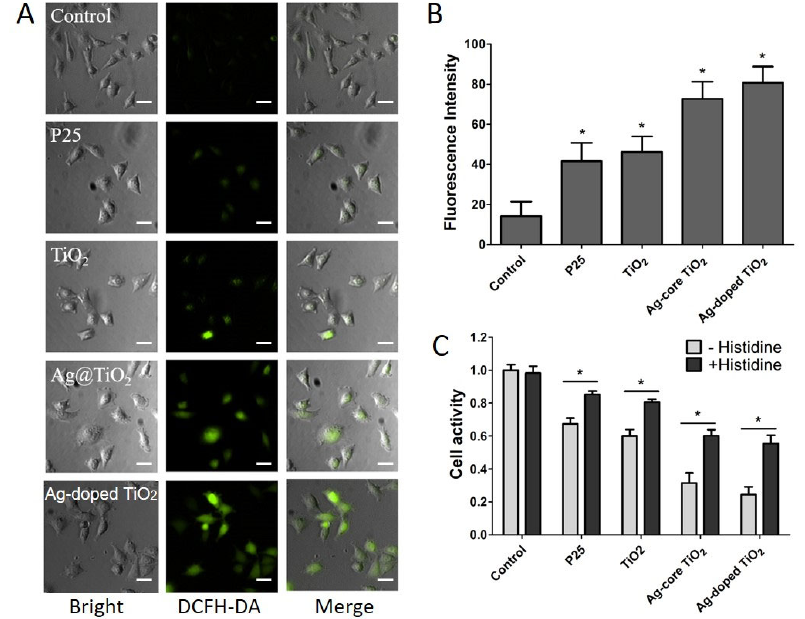
Figure 5. The ROS generation induced by Ag-core TiO 2 and Ag-doped TiO 2 and ROS inhibition using histidine compared with P25 and the synthesized TiO 2 ; ( A ) Fluorescence imaging of ROS generation using DCFH ‐ DA probe on A375 cells; ( B ) Fluorescence intensity assay of ROS generation for DCFH ‐ DA probe on A375 cells. ( C ): ROS inhibition using 20 mM histidine for 30 min on A375 cells. The bar is 20 μ m or SD. *, p < 0.05, represents statistically significant difference between the treated histidine group and the untreated histidine group in P25, the synthesized TiO 2 , Ag ‐ core TiO 2 , Ag ‐ doped TiO 2 , and control.